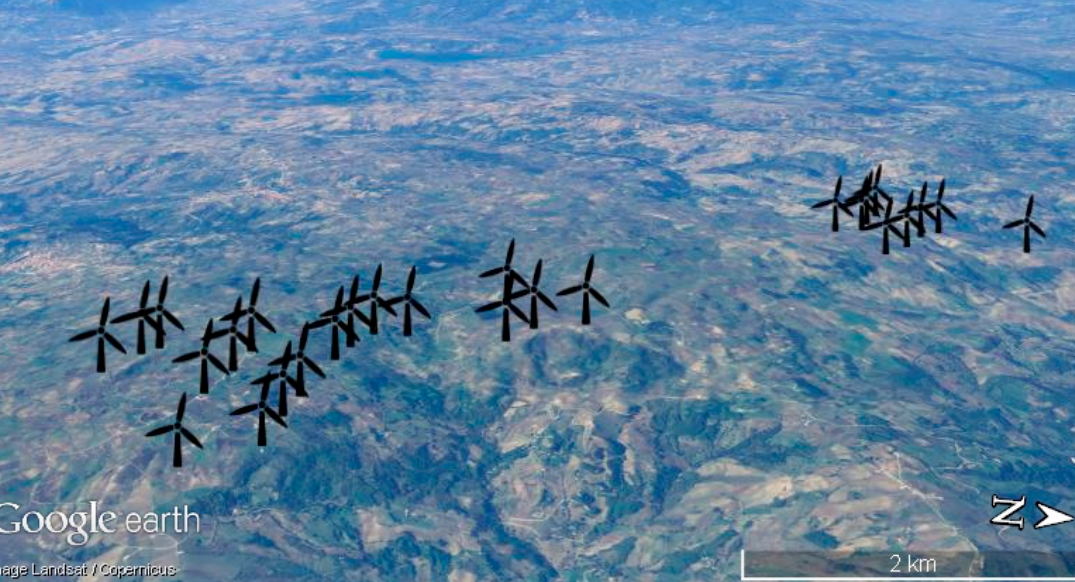
Table 1. Performance Indexes: Proposed Method.